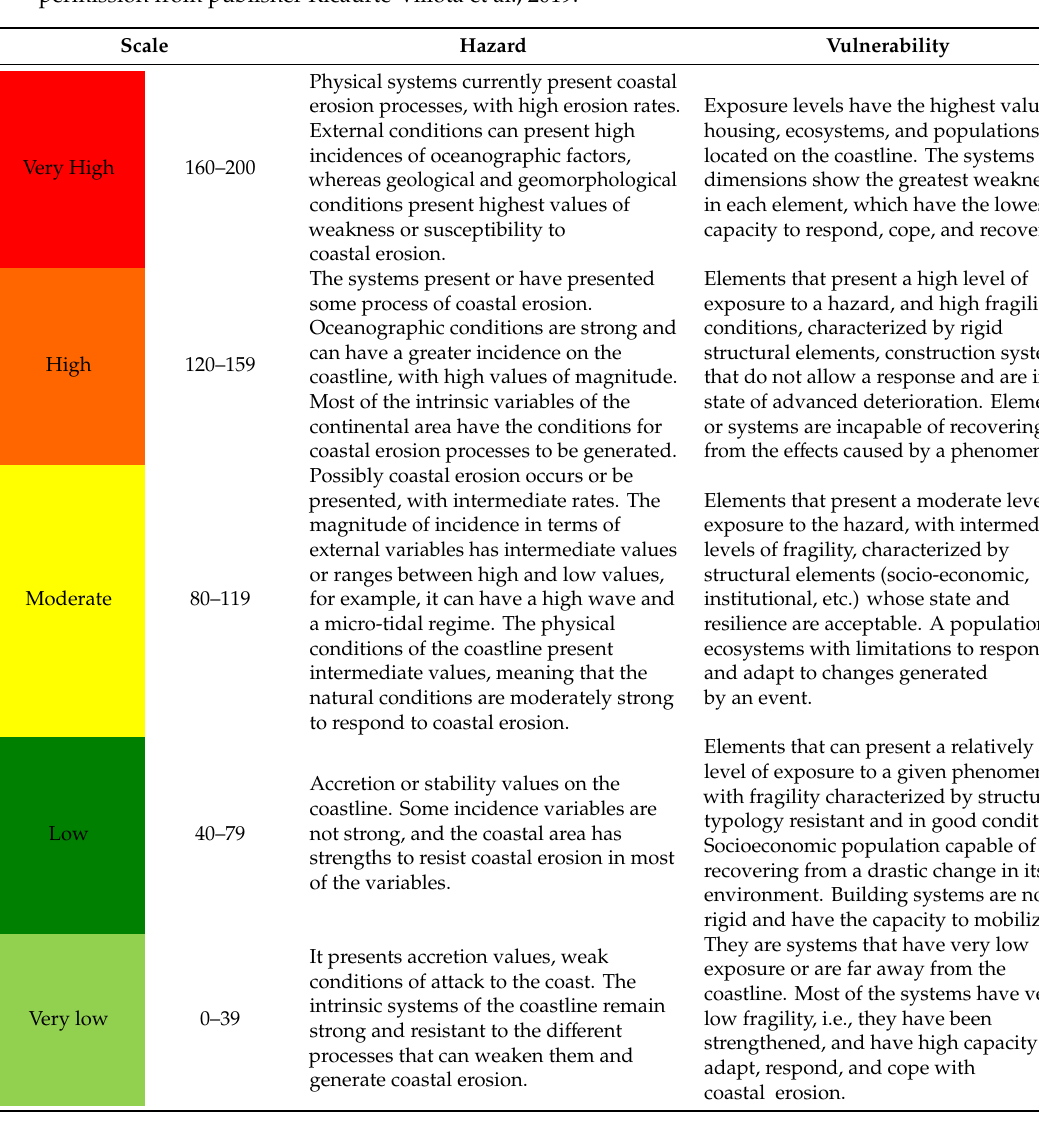
Table 3. Equivalence ranges, reference colors, and their descriptions. Adapted from [54], with permission from publisher Ricaurte-Villota et al.,